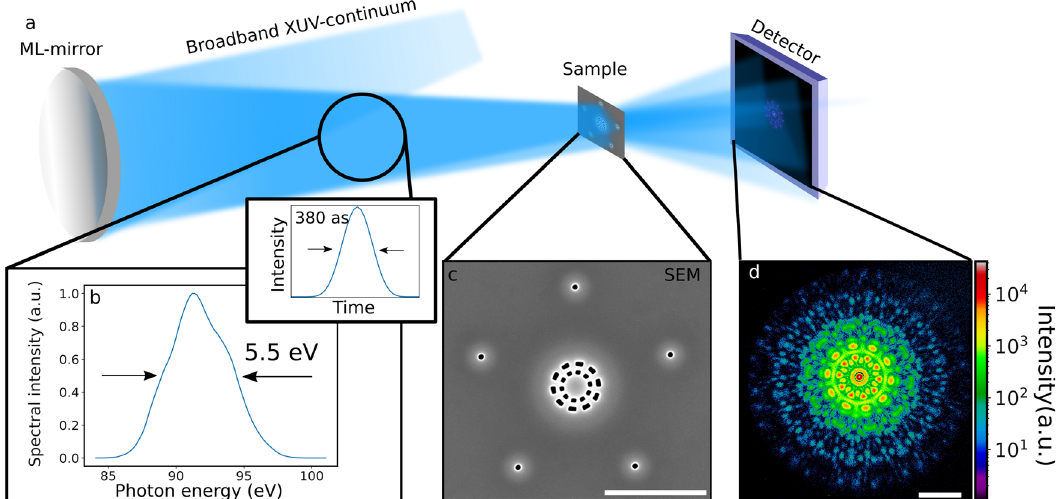
Fig. 1 Schematic representation of the experiment. a A spatially coherent high-harmonic beam is focused on the sample using a broadband multilayer mirror (ML-mirror). From the broadband extreme ultraviolet (XUV) continuum a bandwidth of 5.5 eV is selected at a central photon energy of 92 eV. The resulting spectrum is shown in arbitrary units (a.u.) in b . The small inset shows the Fourier transform of the spectrum assuming a fl at spectral phase, which yields a Fourier limited pulse duration of 380 as. c SEM (scanning electron microscope) image of the sample: a resolution-test pattern is located in the center and surrounded by fi ve reference apertures. The scale bar in c corresponds to 2 µ m and color white correspongs to a high secondary electron intensity. d Measured (intensity) hologram of the sample in log-scale. The scale bar in d corresponds to 10 µ m − 1 and the intensity is shown in arbitrary units